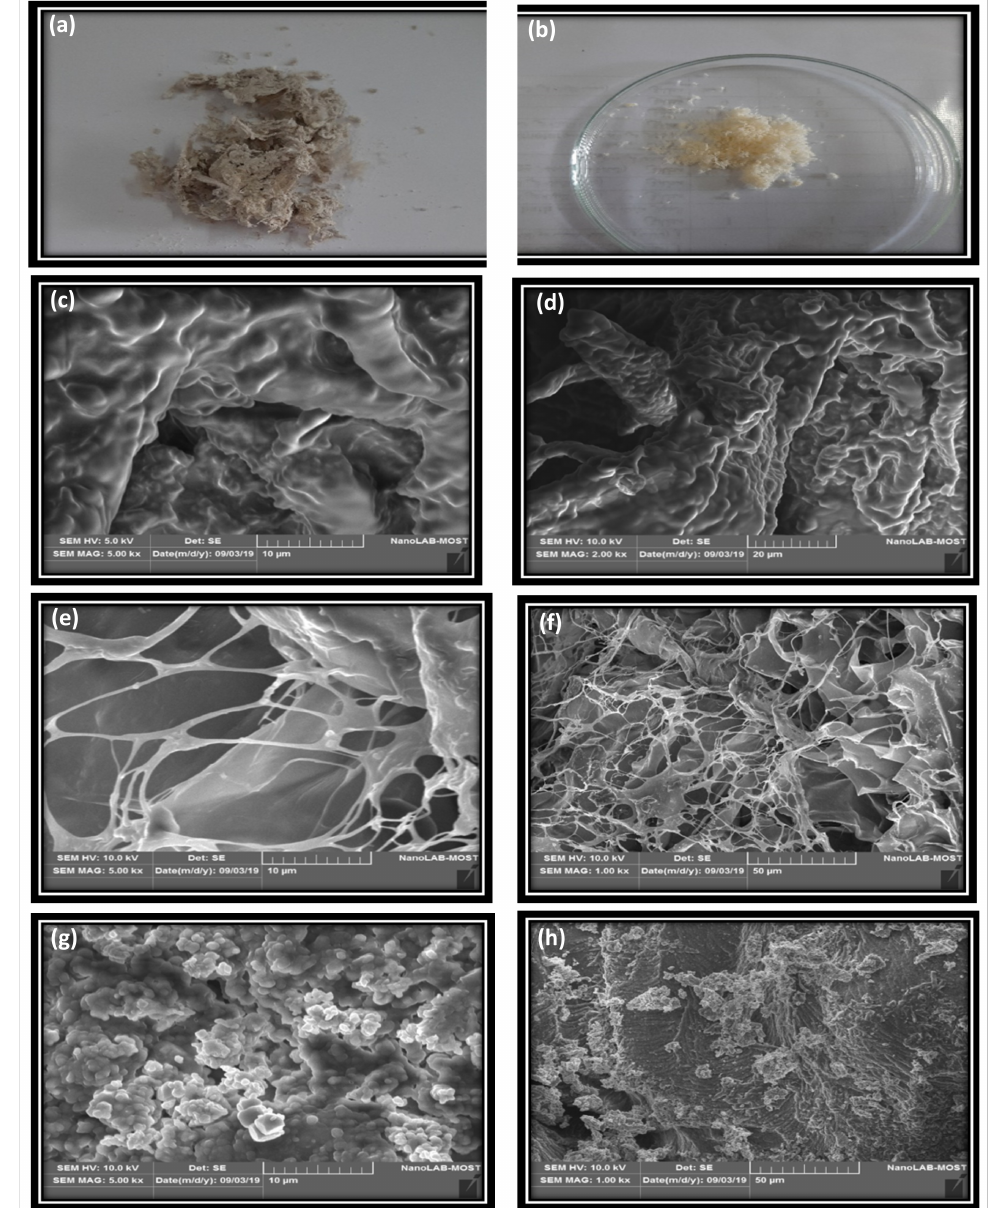
Figure 5. Visual representation of ( a ) ASC, ( b ) PSC, and microscopic structures of ( c ) SEM standard type I collagen at 10 mm, ( d ) SEM standard type I collagen at 20 µ m, ( e ) ASC at 10 µ m, ( f ) ACS at 50 µ m, ( g ) PSC at 10 µ m, ( h ) PSC at 50 µ